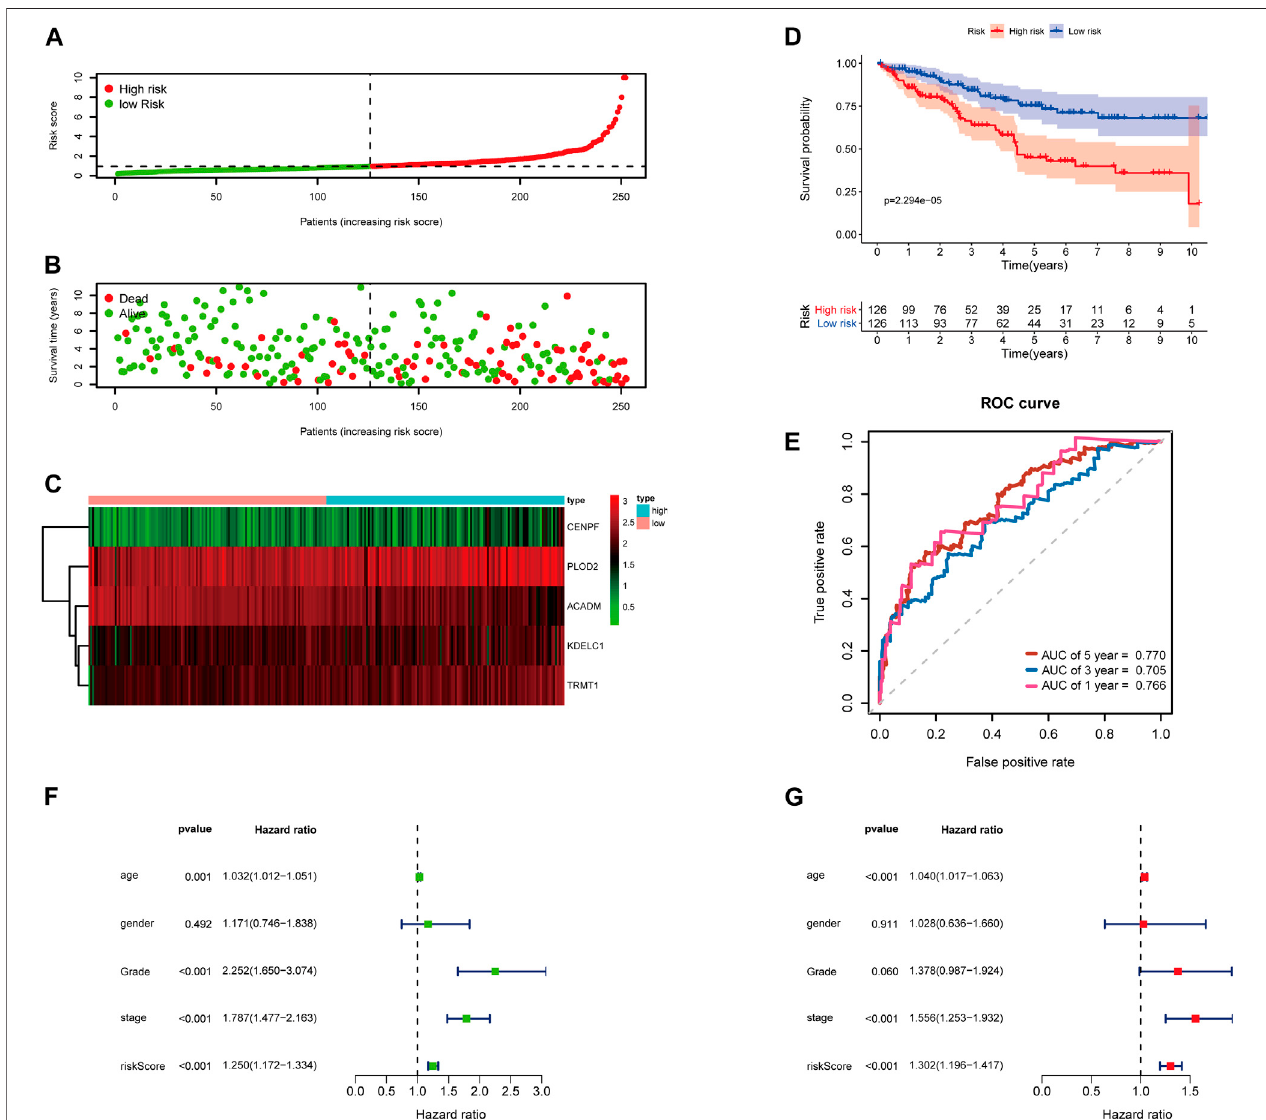
FIGURE 3 | Risk score analysis of the 5-gene signature based on SARS-CoV-2 – related genes in the training set. (A – C) Distribution of risk scores, OS status, and geneexpressionofmodelgenes; (D) Kaplan – Meiercurvesofthehigh-andlow-risksubgrouppatients; (E) Time-dependentROCcurvesforpredicting1-,3-,and5-year OS; (F) Univariate and (G) multivariate Cox regression analyses in the training set.